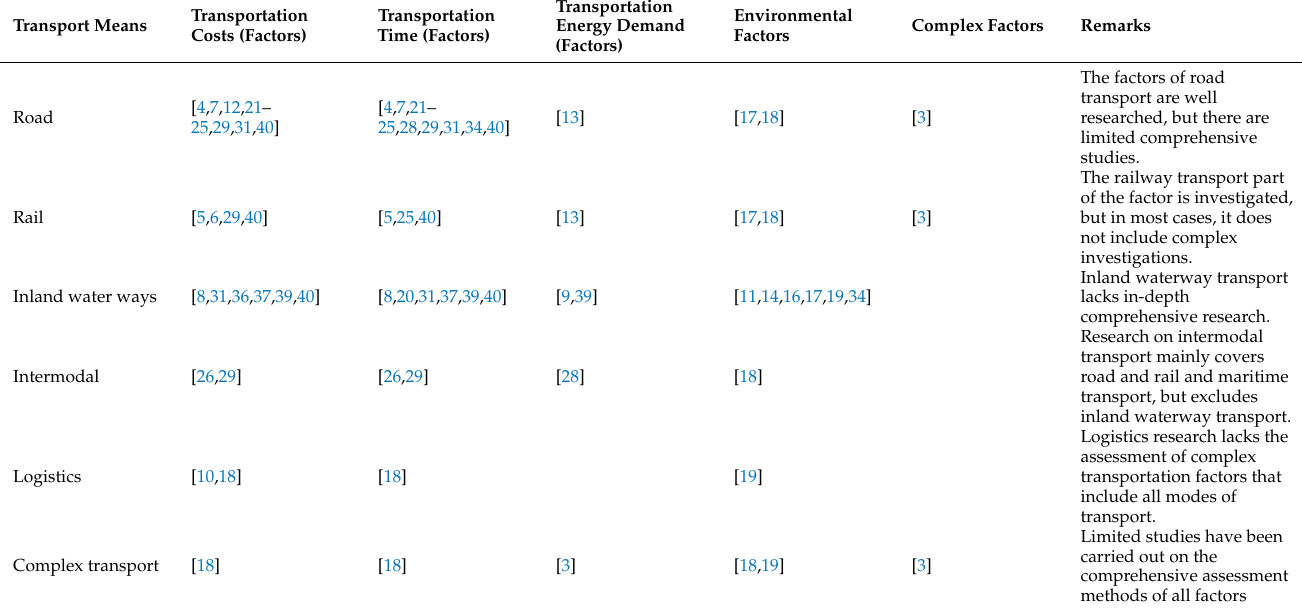
Table 2. Analysis of the research methods of the transport modes different factors.